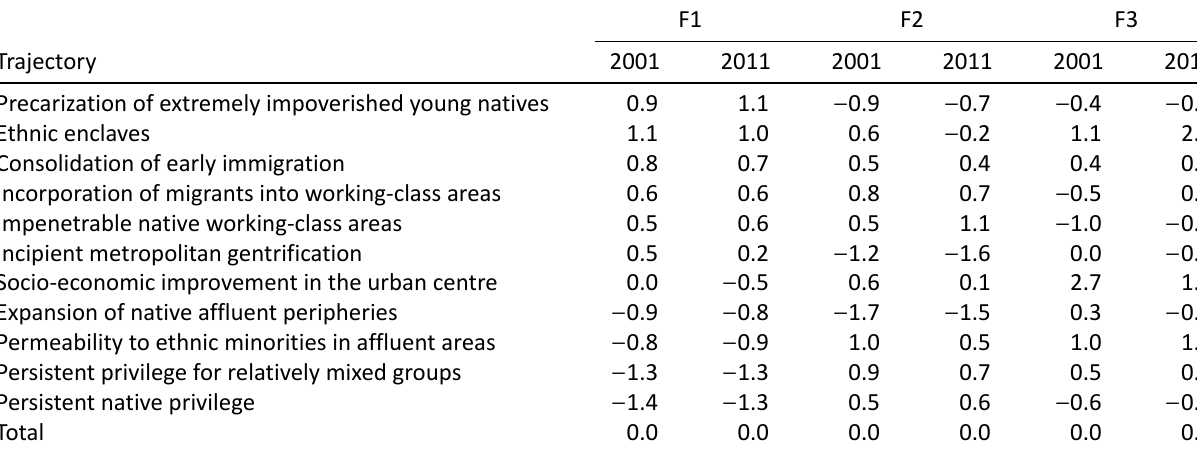
Table 5. Social residential inequality index according to the type of social residential trajectory.